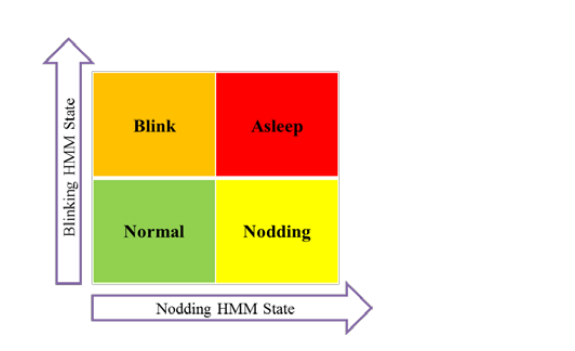
Table 2. Comparison of fitting performance between AAM (Active Appearance Model)and DB-ASM (Discriminative Bayesian-Active Shape Model).